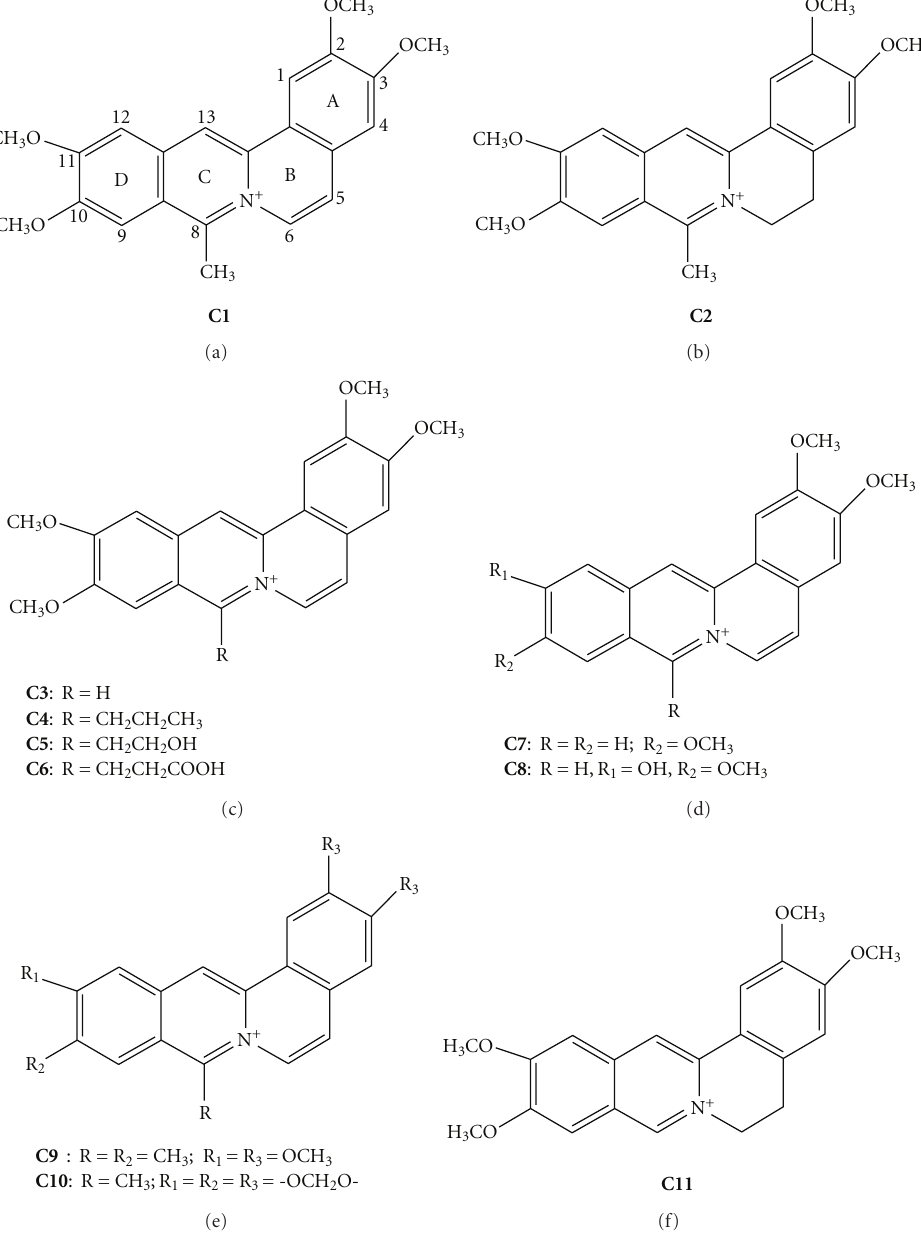
Figure 11: Chemical structures of several coralyne